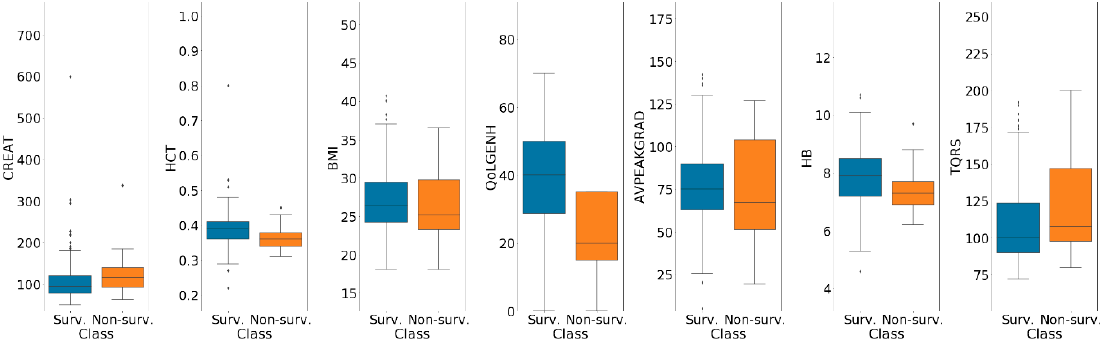
Figure A1. Boxplots of numerical features are shown for both classes of the population. Non ‐ survived and survived patient distributions are shown in orange and blue, respectively.